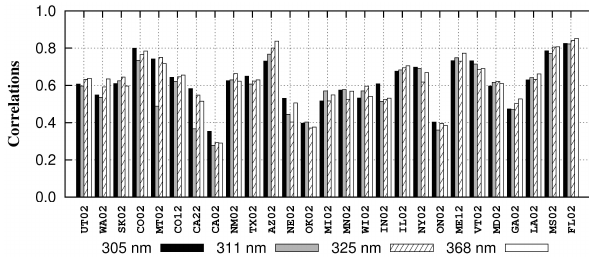
Fig. 5. The temporal correlations of the TOMS irradiance bi- ases from the UVMRP measurements with in-situ optical depths at 368nm observed by UVMRP at each monitoring site for 305, 311, 325, and